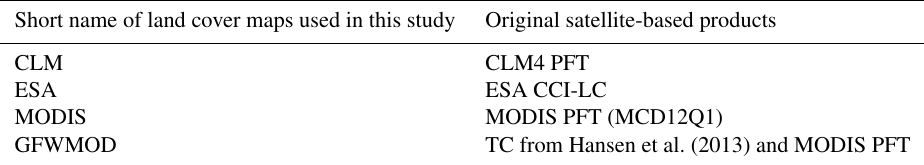
Table 2. Land cover maps considered in this study, including their labels and the datasets on which they are based (described in Table 1). The target period of this study is 2001–2016.